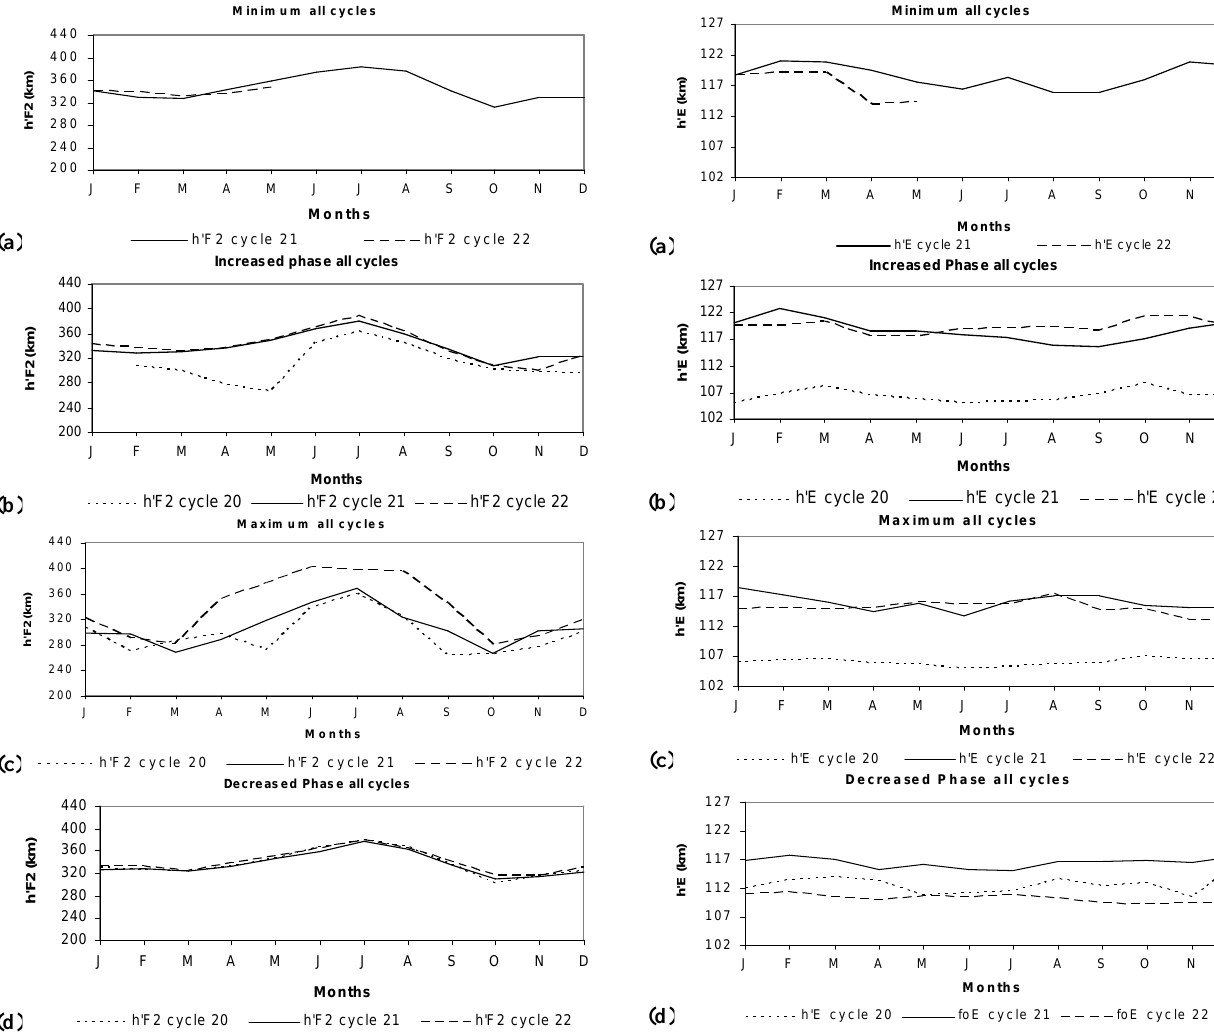
Minimum all cycles